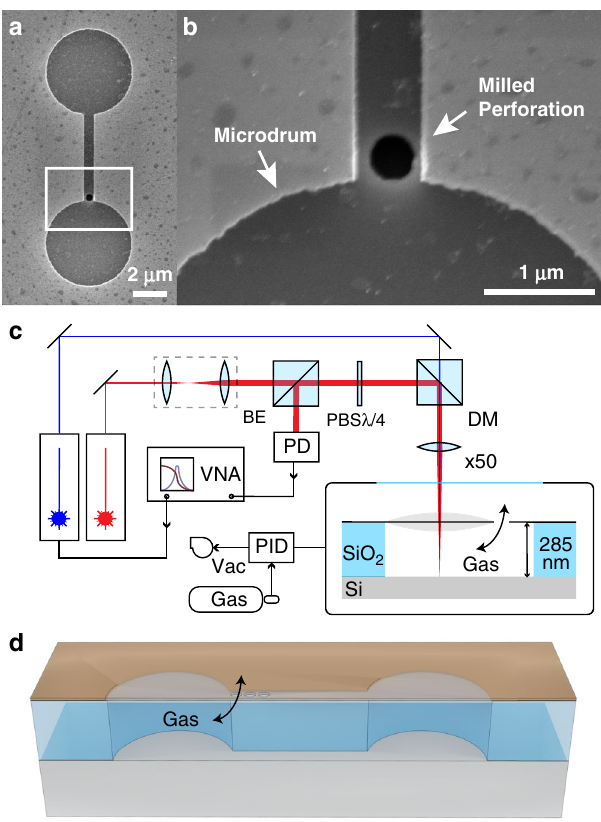
Fig. 1 Suspended graphene device and measurement setup. a Electron microscope image of a dumbbell shaped cavity covered by bilayer graphene. b A nanopore with a diameter of 400nm is milled in the graphene by an ion beam in the channel that connects the two micro drums. c Interferometry setup used to actuate and detect the motion of the graphene micro drums. The red laser passes subsequently through the beam expander (BE), the polarised beam splitter (PBS) and the quarter- wave plate ( λ /4), after which it is combined with the blue laser using a dichroic mirror (DM) and focused on a micro drum using a 50x objective. The readout is performed by a high-frequency photodiode (PD) that is connected to the Vector Network Analyser (VNA). The VNA modulates the power of the blue laser that actuates the membrane. Gas pressure inside the vacuum chamber is controlled by a PID controller. d Schematic of the device geometry and gas effusion